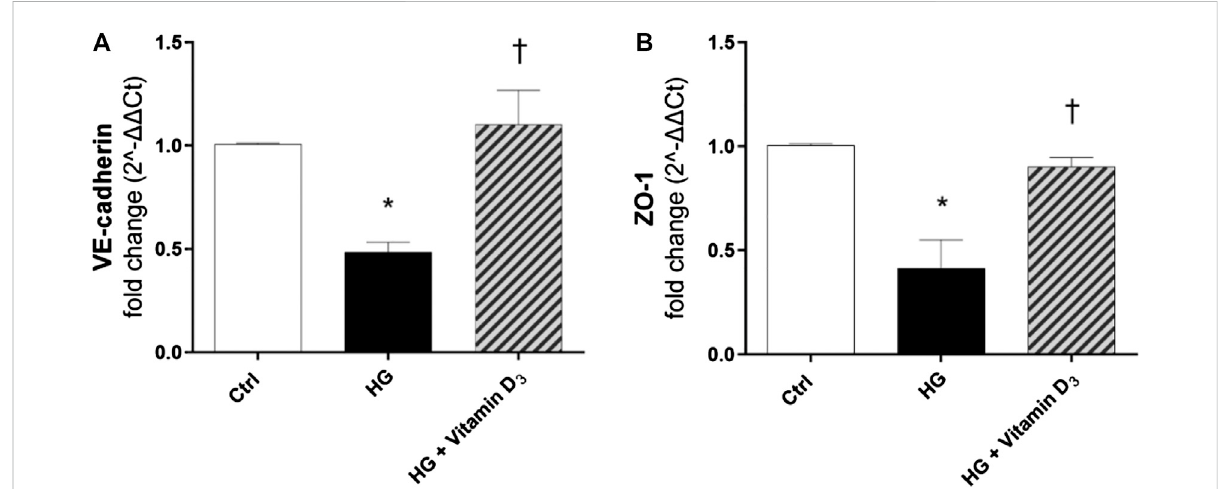
FIGURE 4 VitaminD 3 inducesVE-cadherinandZO-1mRNAexpression.VE-cadherin (A) andZO-1 (B) mRNAlevelsaftertreatmentwithvitaminD 3 andHG for 48 h. Values are reported as mean ± SD; n = 4. Data were analyzed by one-way ANOVA and Tukey post-hoc test for multiple comparisons. * p < 0.05 vs. control; † p < 0.05 vs.